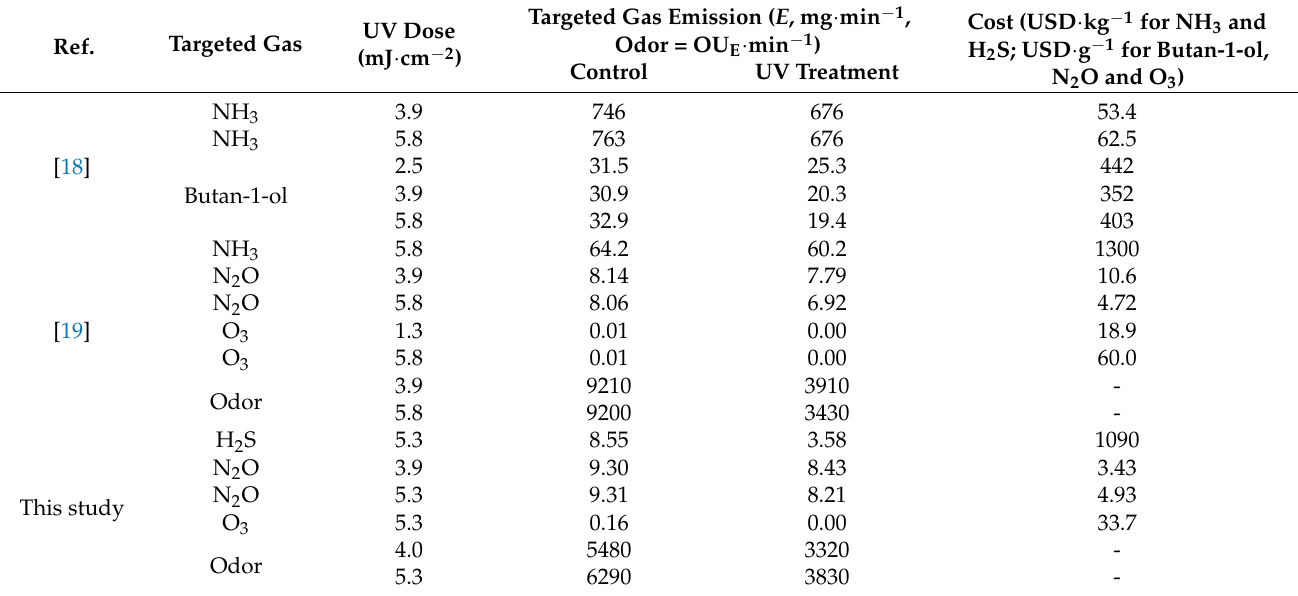
Table 16. Summary of the estimated cost of electric energy needed to mitigate targeted gases with UV-A photocatalysis using the mobile lab.